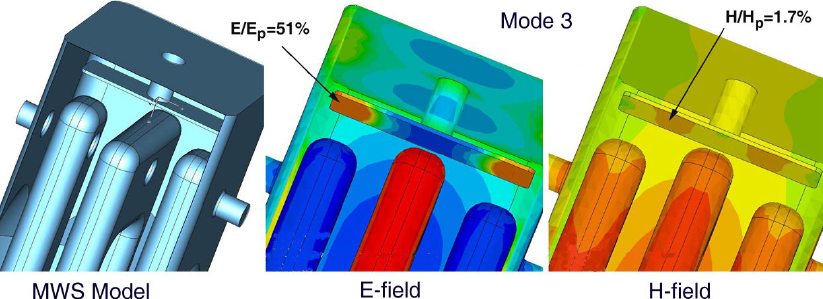
, blue signifies negative p (cid:6) 51% , shown in Fig. 9, and E=E bar is E=E is below p p 1.7% on the surface of the support plate.